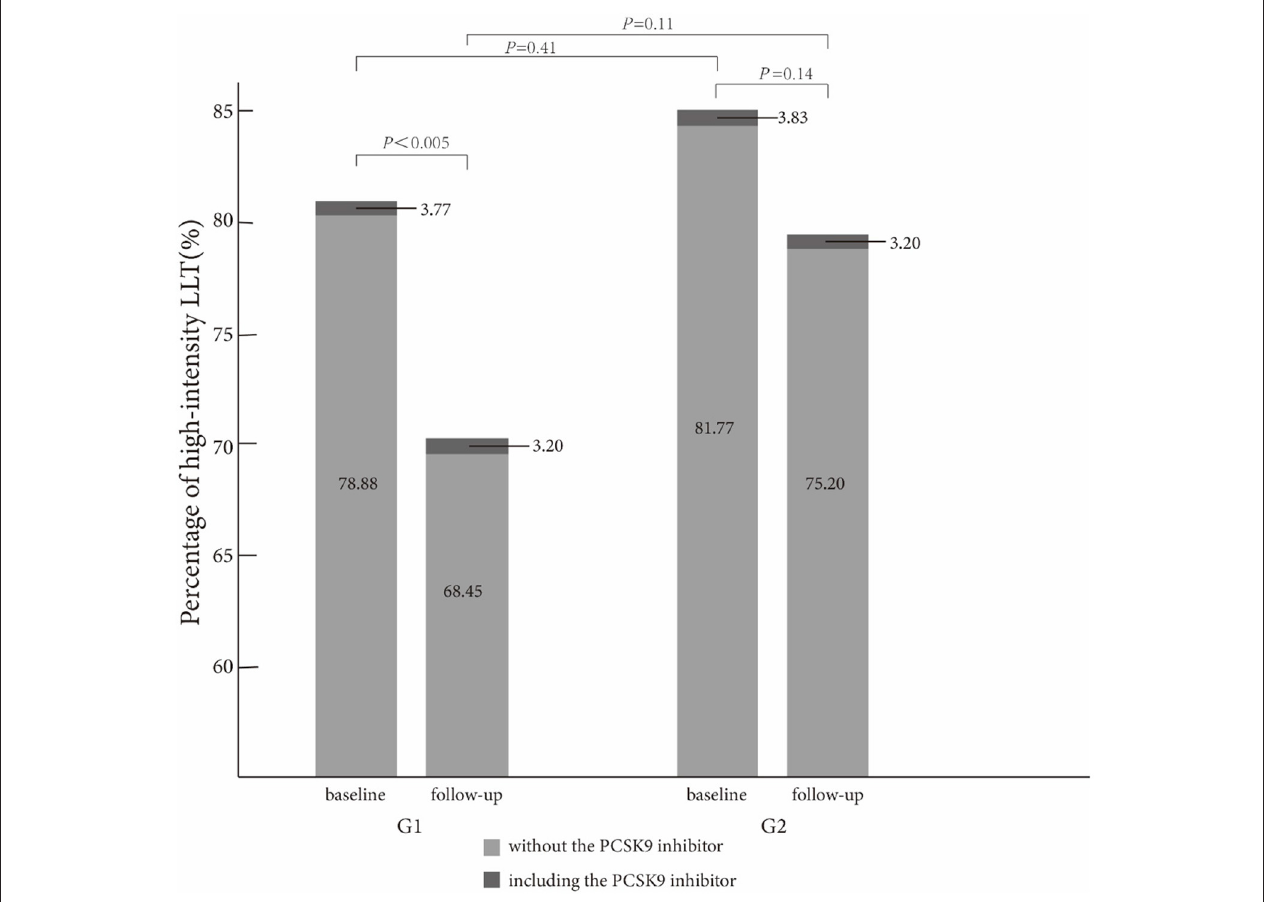
FIGURE 1 | Comparison of high-intensity lipid-lowering therapy strategies between the two groups at baseline and follow-up.